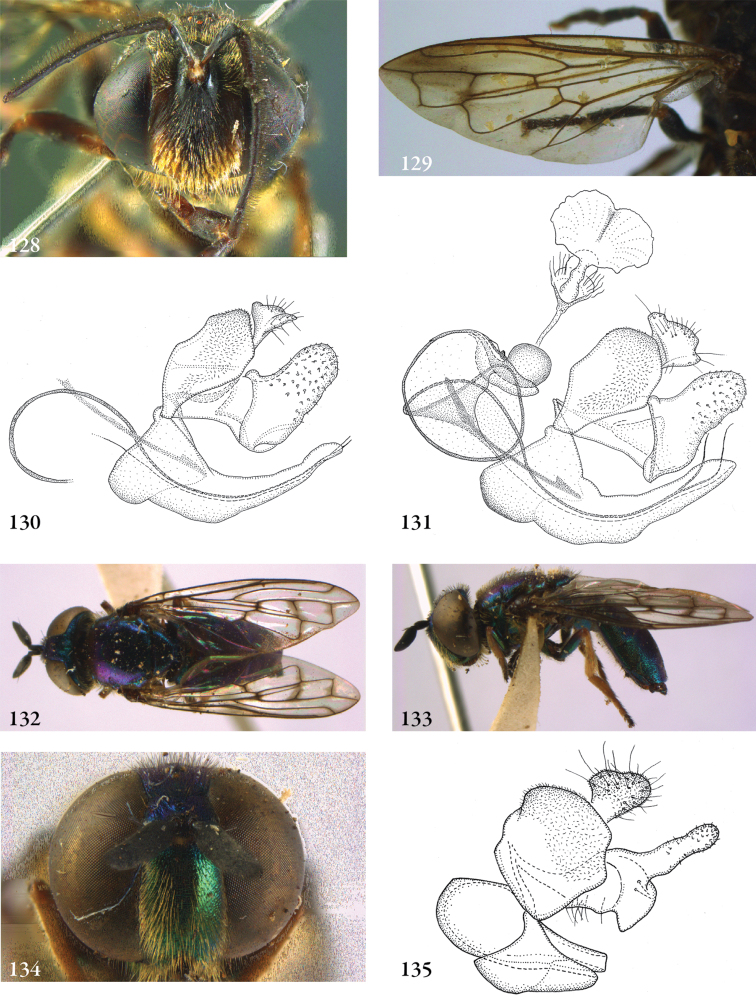
Figures 128–129.
Kryptopyga sulawesiana male (holotype): 128 head frontal 129 wing 130–131
Kryptopyga, male genitalia 130
Kryptopyga pendulosa (holotype) 131
Kryptopyga sulawesiana (holotype) 132–134
Laetodon violens male (Jamaica, coll. RMNH): 132 habitus dorsal 133 habitus lateral 134 head frontal 135
Laetodon laetus male (USA, Georgia, coll. RMNH), genitalia lateral.